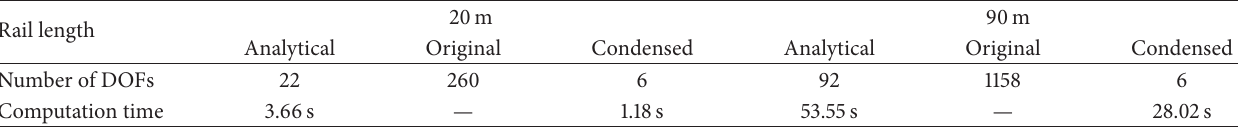
Table 4: Comparison of the computation times of the analytical model, the original wheel-rail contact FE model, and the condensed model